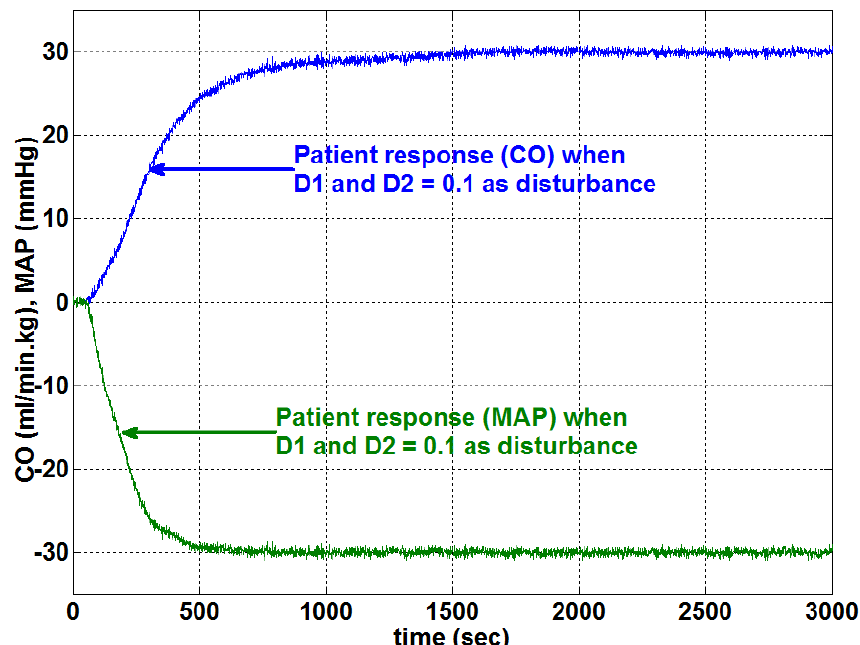
Figure 12: Nominal response with disturbance variance D1=D2=0.1 and set points +30 for CO and -30 for MAP